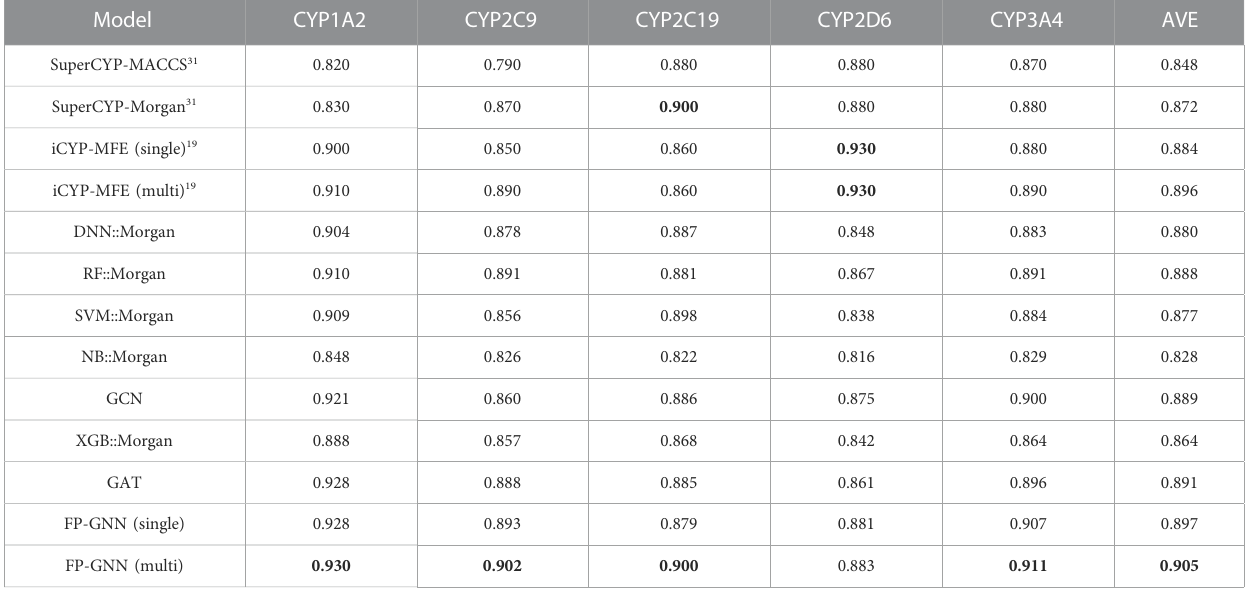
TABLE 1 The AUC value of FP-GNN on CYPs dataset compared to other baseline models.